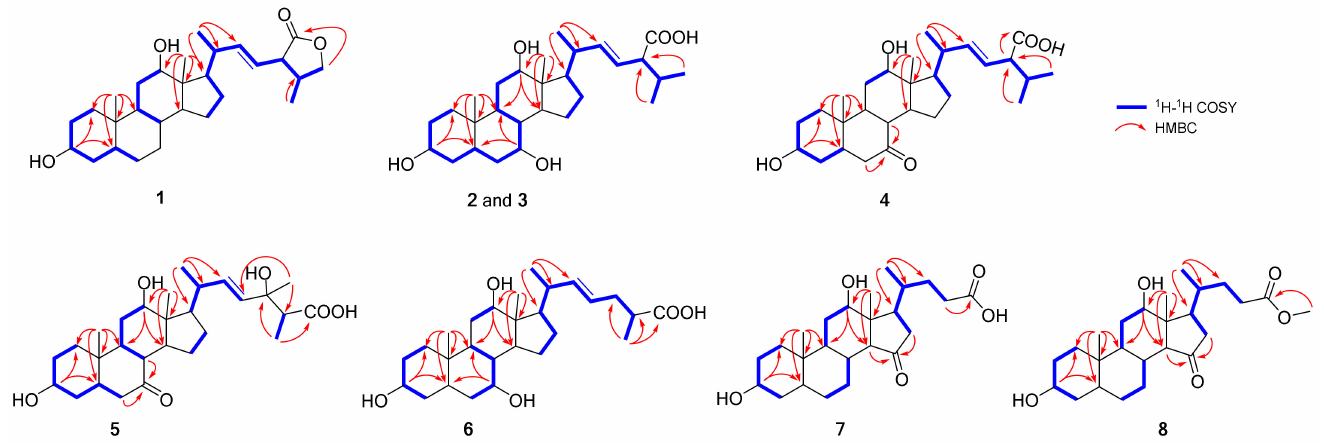
Figure 2. Key 1 H- 1 H-COSY (blue bold) and HMBC (red arrow) correlations of 1 – 8 .